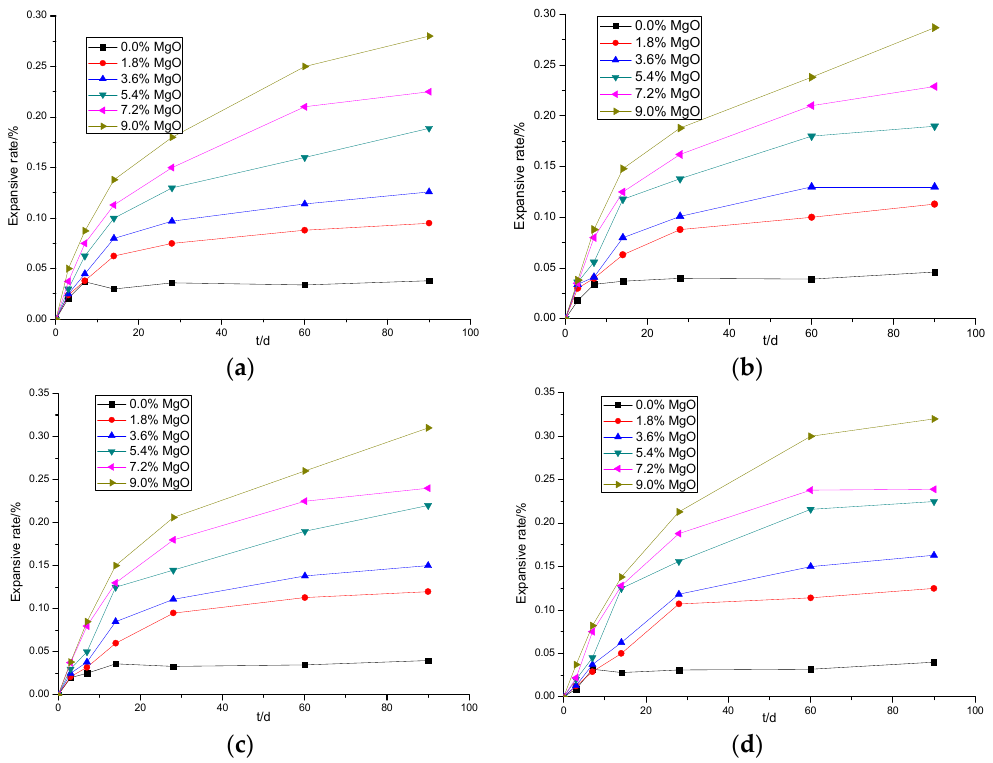
Figure 3. The expansion curves of cement paste mixed with MgO of different activities and amounts at 20 °C curing: ( a ) M65 s; ( b ) M110 s; ( c ) M143 s; ( d ) M190 s.